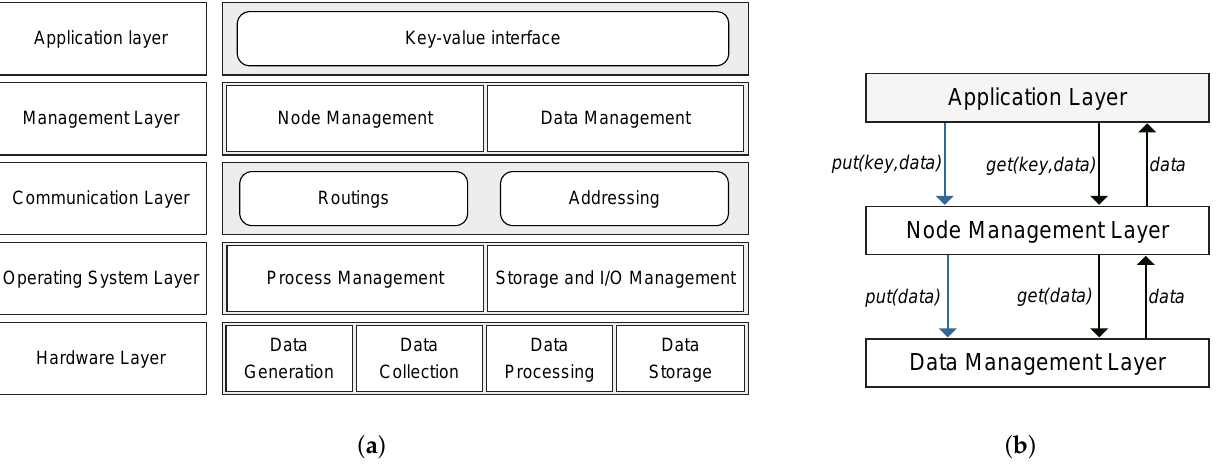
Figure 3. ( a ) Functional architecture of the proposed Chord-based Fog system. ( b ) Logical structure between application and management